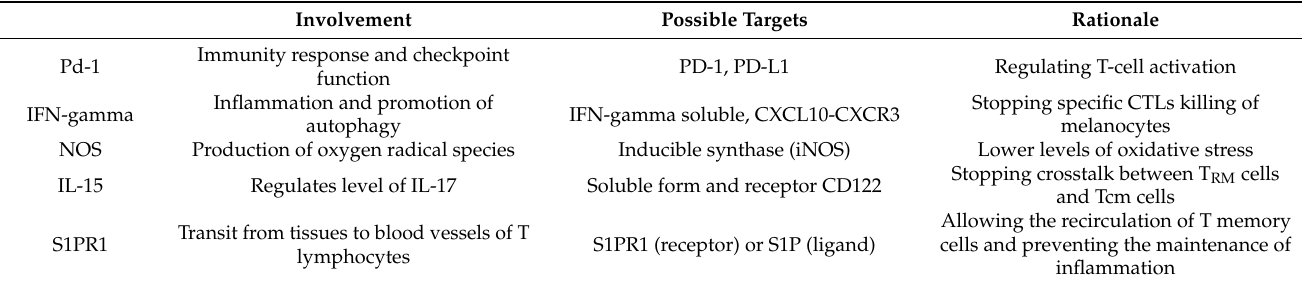
Table 2. Possible targets for the treatment of vitiligo, known effects on melanocytes, molecules related to the objectives, scientific